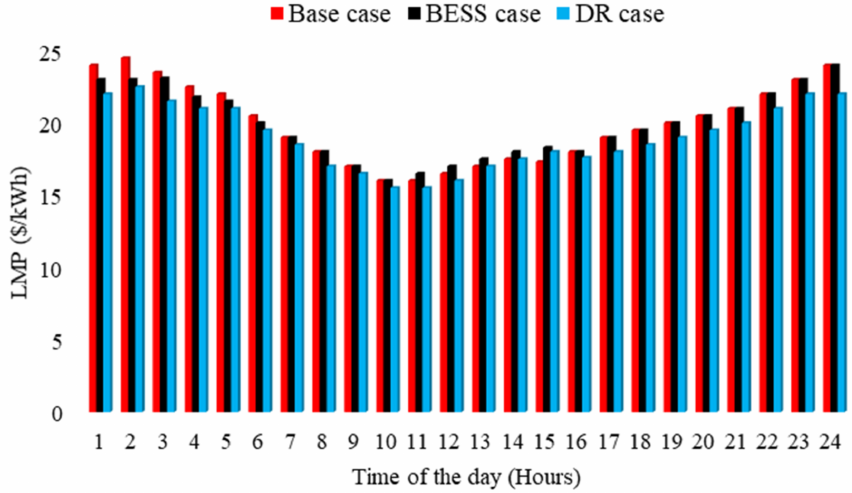
Figure 9. LMPs at Candidate Bus